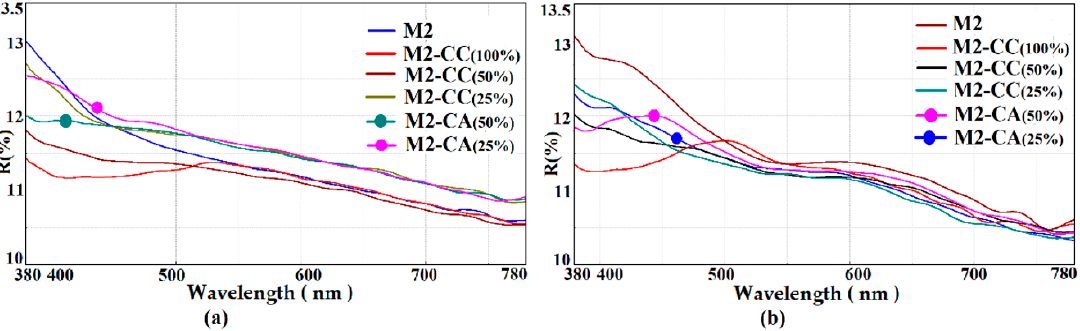
Figure 8. UV-Vis reflectance spectra of M2 hybrid coatings with different dyes loadings deposited on ( a ) glass, ( b ) PET.